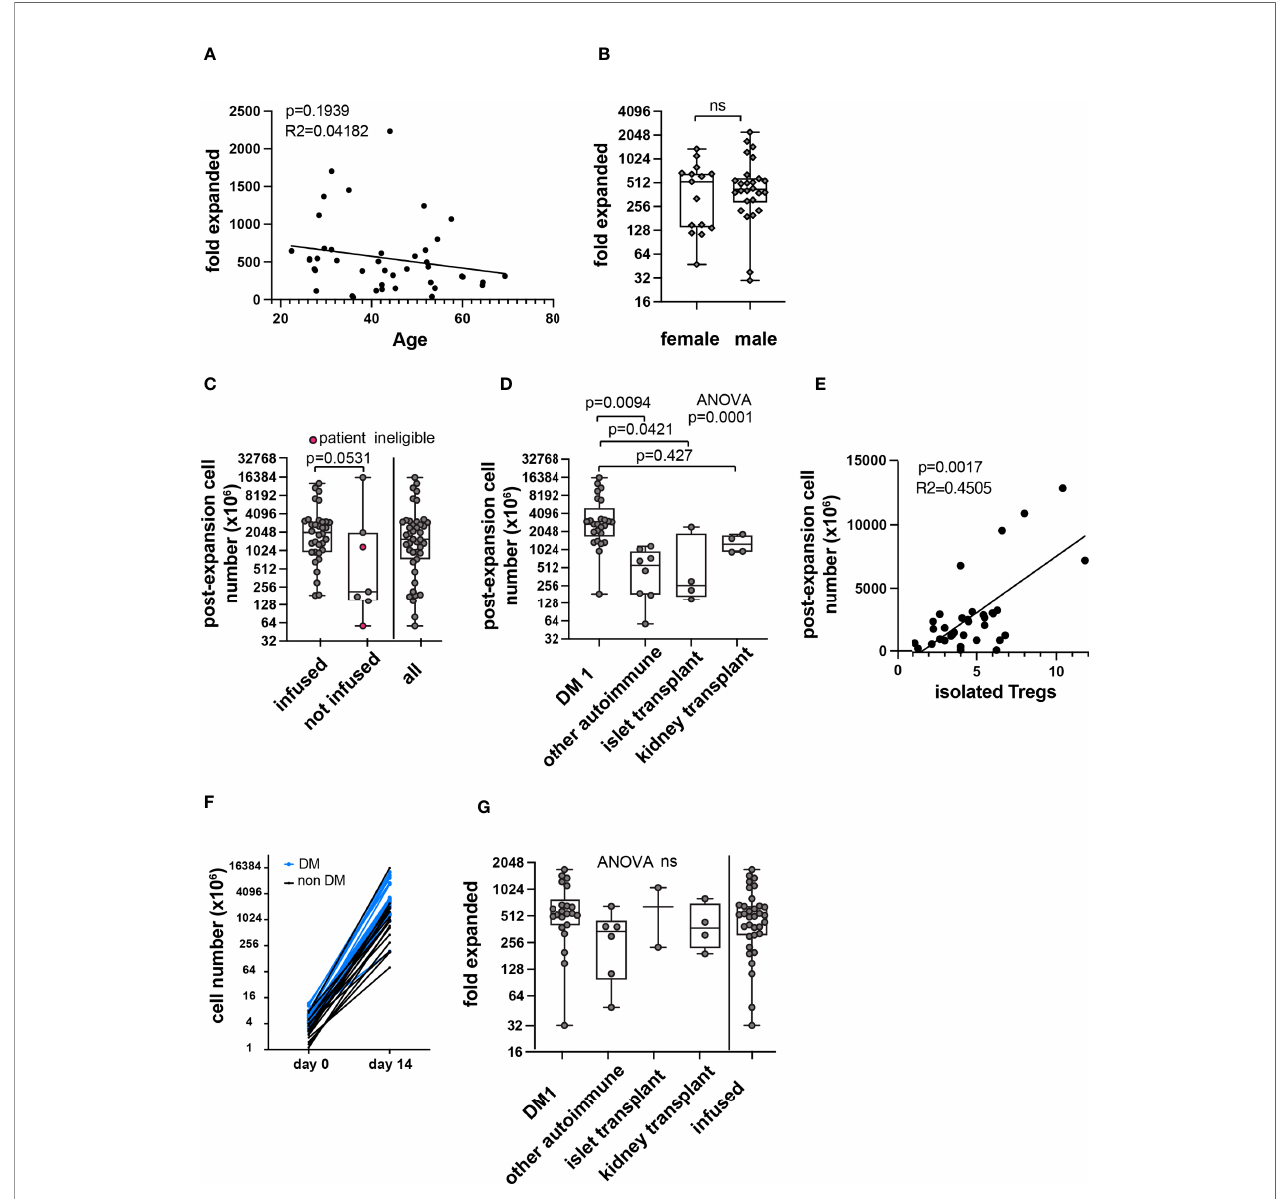
FIGURE 5 | Correlations with PolyTreg products in-vitro expansion. Correlation between age (A) or sex (B) and Treg fold expansion. Post expansion Treg number in all products (n=41) in millions by infusion status or total (C) . Pink circles in the second column indicate patient ineligibility for infusion. The remaining data points in the “ not infused ” column represent manufacturing failures. Post-expansion cell number subcategorized by indication (n=41) (D) . Post-expansion cell number plotted against isolated Treg number (E) with simple linear regression (n=36). Isolated and post-expansion cell number plotted individually by patient (n=36) (F) . Blue lines and symbols represent patients with type 1 diabetes, black lines and symbols represent all other indications. Fold-expansion by indication or among all infused products (n=36) (G) . R squared (R 2 ) values and p-value assess goodness of fi t, and signi fi cance of slope not equal to zero. In box and whisker plots, the box shows mean and quartiles, whiskers show minimum and maximum values. ns, not statistically signi fi